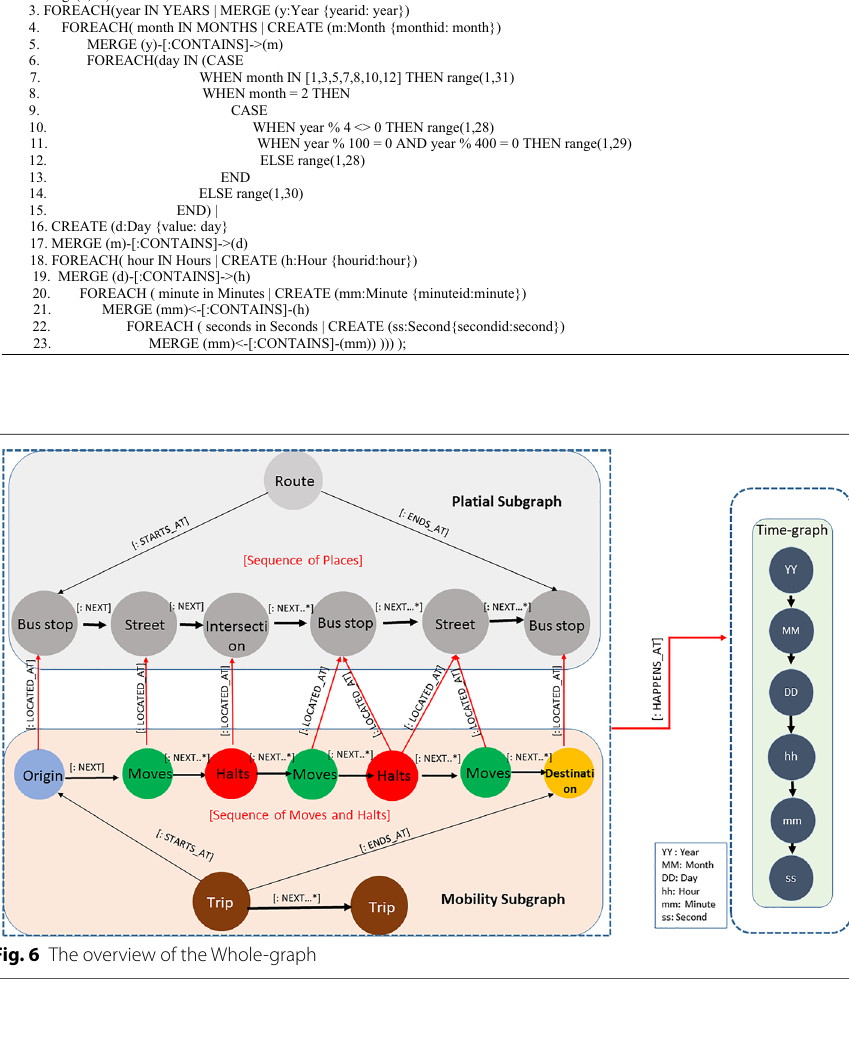
Table 6 Cypher query for creating the time-graph 1. WITH range(2016, 2017) AS YEARS, range(1-12) as MONTHS, range() as Days, range(1,24) as Hours, range(1,60) as Minutes, 2. range(1,60) as Seconds 3. FOREACH(year IN YEARS | MERGE (y:Year {yearid: year}) 4. FOREACH( month IN MONTHS | CREATE (m:Month {monthid: month}) 5.